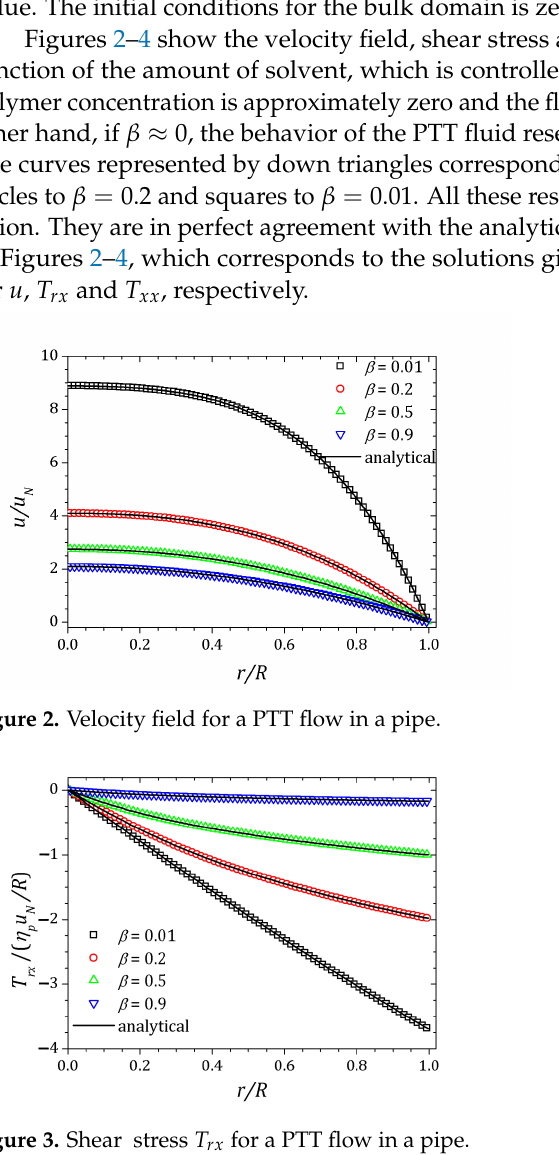
Figure 3. Shear stress T rx for a PTT flow in a